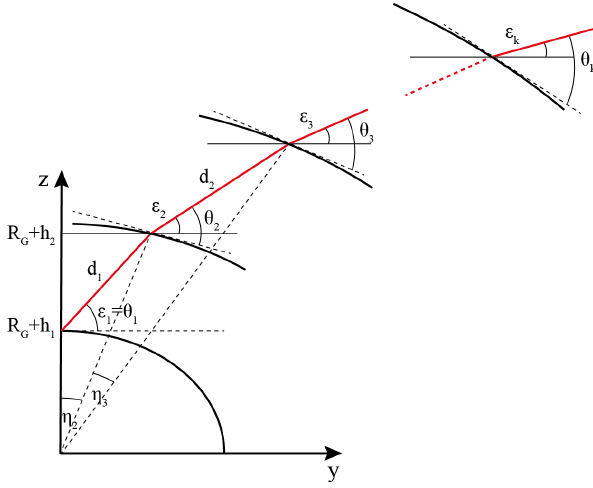
Figure 1. Geometry of the ray-tracing approach with the geocentric coordinates (y,z) , the geocentric angles (η,θ) , elevation angle ε and d as the distance between two consecutive ray